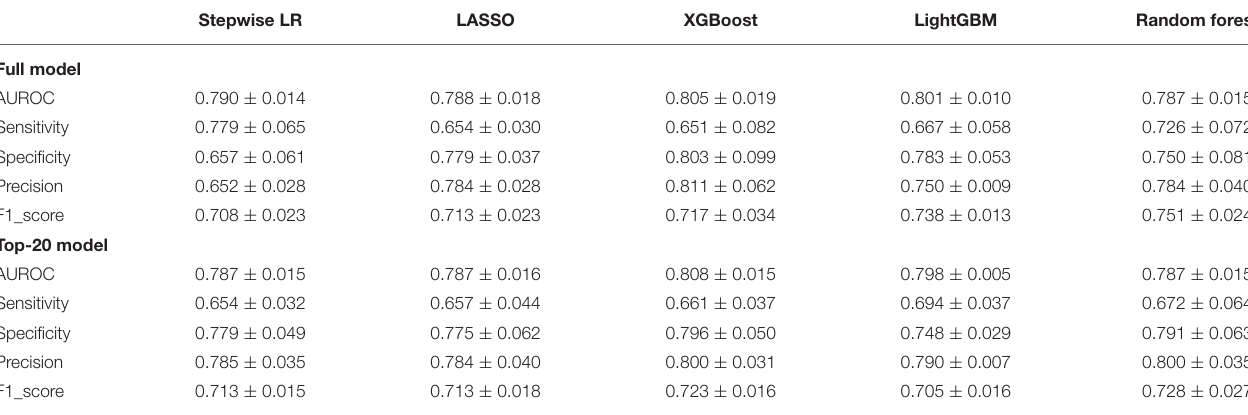
TABLE 2 | Summary of model comparisons for predicting AKI non-recovery in the derivation cohort. Stepwise LR LASSO XGBoost LightGBM Random forest